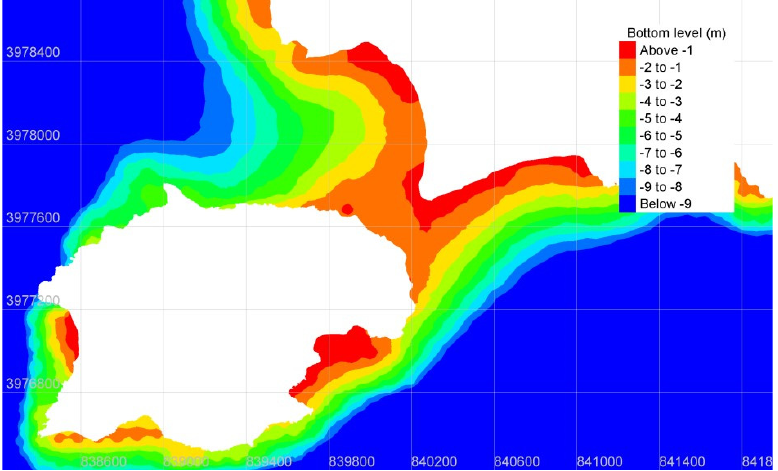
Figure 7. Filled contour map of the bottom level information in the intermediate and shallow water area of interest. Map created in Blue Kenue™ software tool for hydraulic modellers.